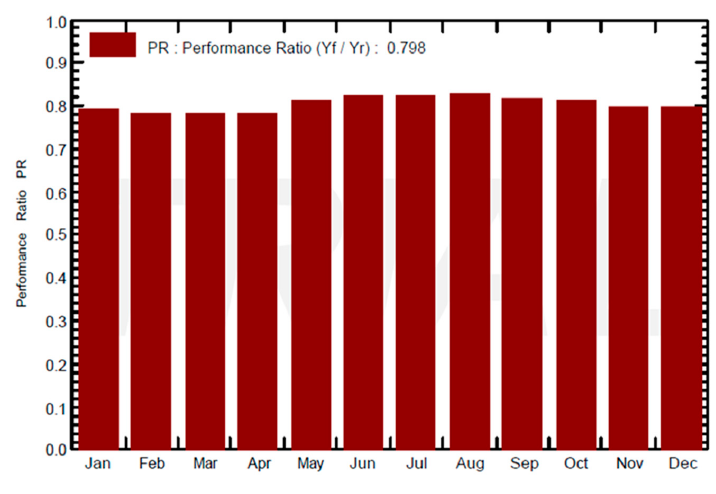
Figure 8. Performance ratio.